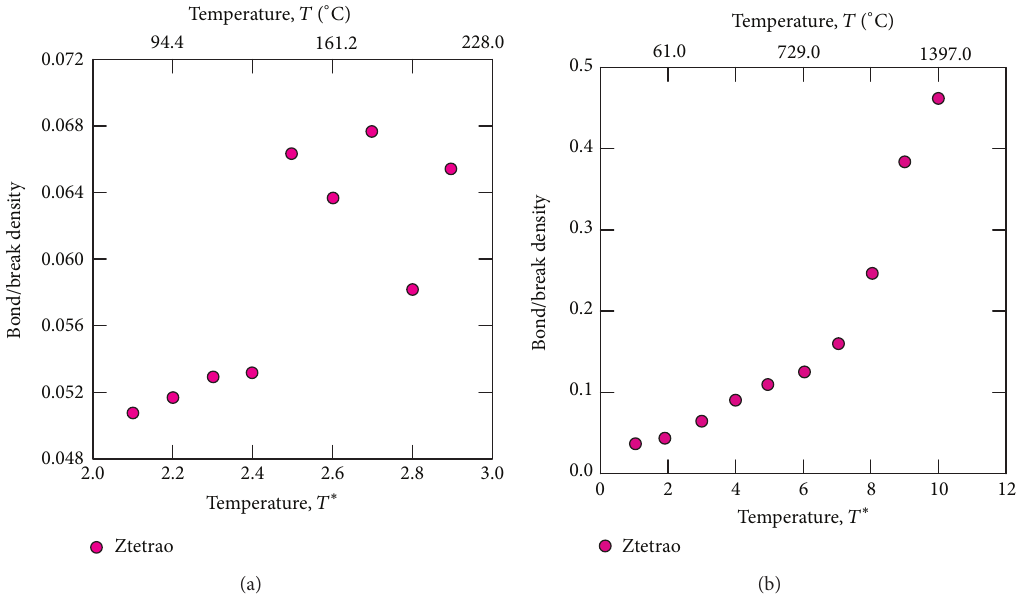
Figure 12: Effects of temperature on the bond/break density of PFPE Ztetraol on a DLC substrate: (a) at a short temperature range; (b) at a long temperature range.